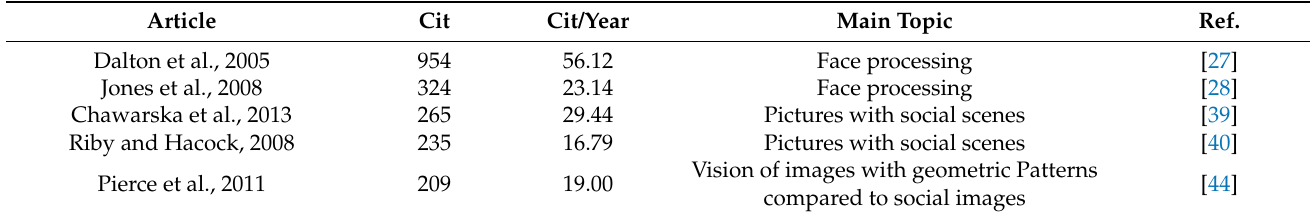
Table 3. Twenty most cited articles focused on autism spectrum